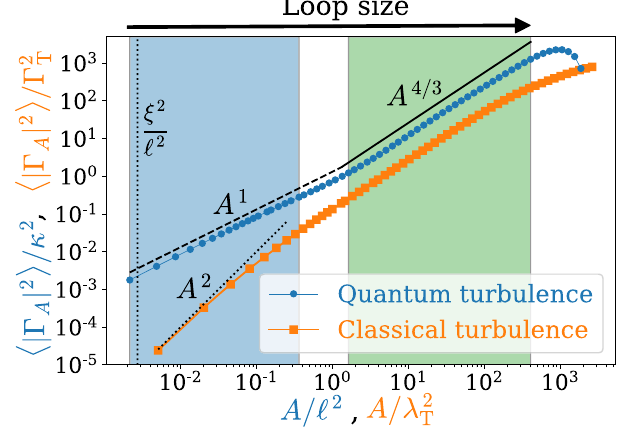
FIG. 2. Variance of the circulation around square loops of area A ¼ r 2 . The blue line shows the gGP simulation (resolution 2048 3 ), and the orange line shows the Navier-Stokes simulation (resolution 1024 3 ). The classical variance is rescaled by Γ 2 = 3 Þhj ω j 2 i , with λ the Taylor microscale and ω the ¼ ð λ 4 T T T vorticity